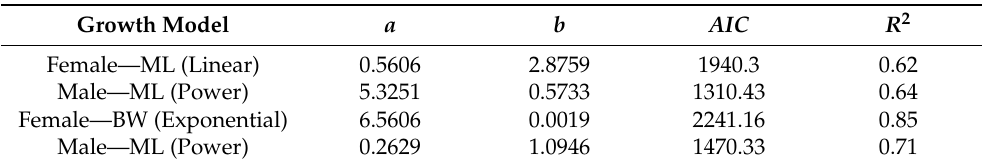
Table 2. Parameters of the growth models fitted to S . oualaniensis mantle length (ML) – age, body weight (BW) – age.